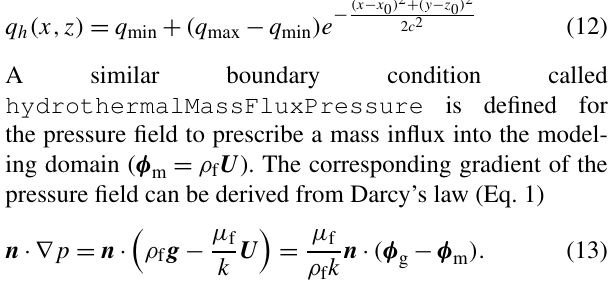
Figure 1. Phase diagram and density of pure water in temperature– pressure space. Red dot denotes supercritical point. The supercrit- ical fluid region is outlined by critical pressure and critical tem- perature lines and is divided by critical density isoline into liquid- like fluid and vapor-like fluid. Three solid curves in different col- ors represent pressure-temperature path of 1-D benchmark exam- ples shown in Fig. 4a, c, and e,